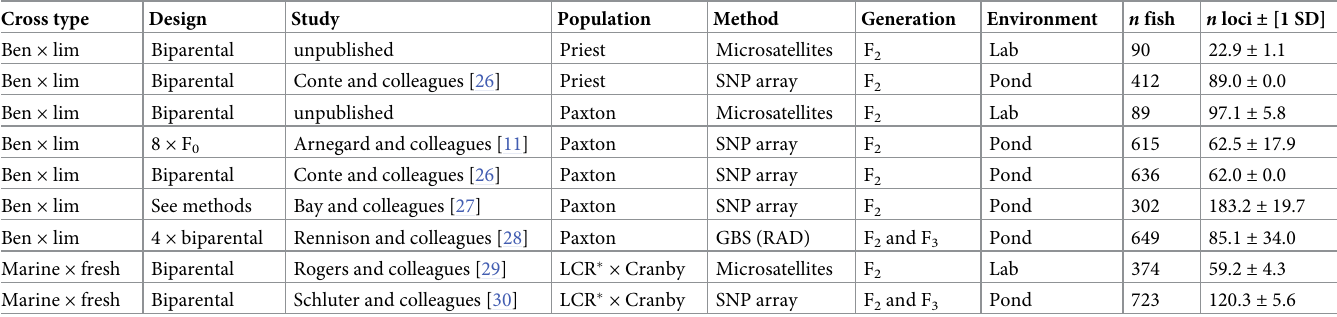
Table 1. AU : PleasecheckifTable 1 ispresentedcorrectly : Summary of data sources. Cross type